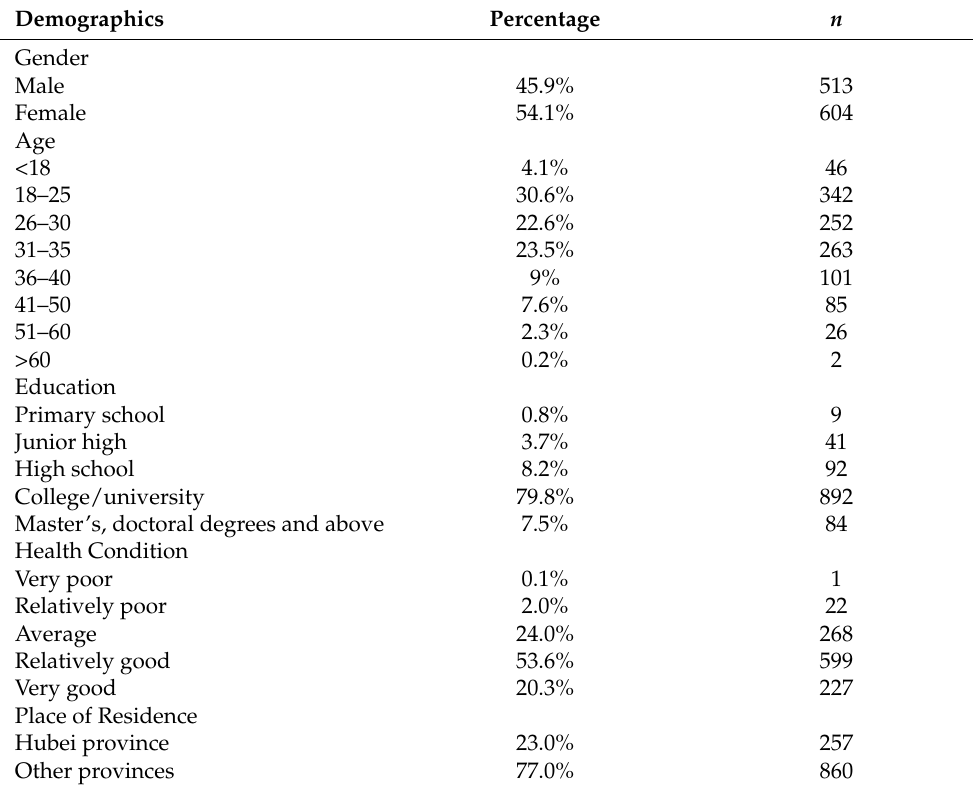
Table 1. Participant